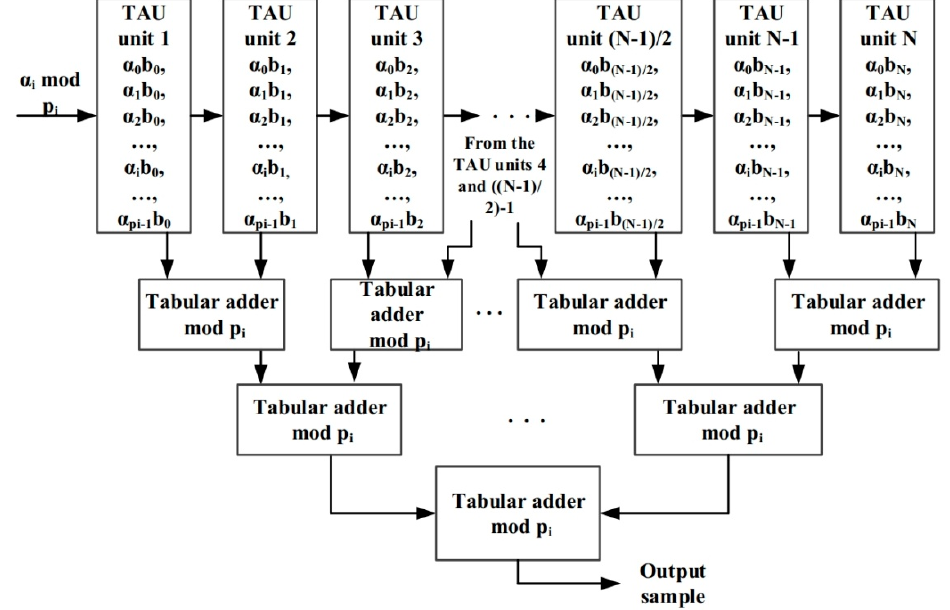
Figure 1. The structure of the DF operating on the basis of the finite residue field algebra. The abbreviation TAU means “Table Arithmetic Unit”.